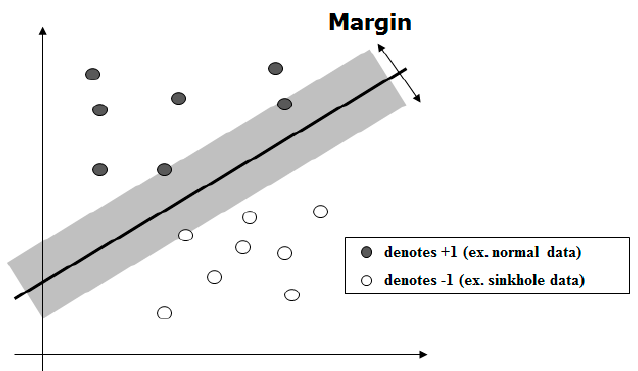
Figure 4. Support vector machine (SVM) model.